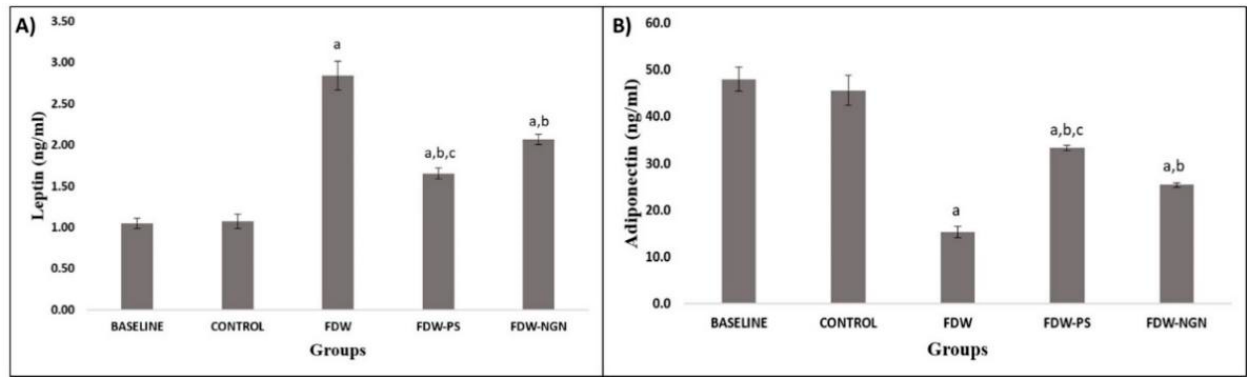
Figure 3. Leptin ( A ) and adiponectin ( B ) levels of all groups over 12 weeks. Values are mean ± SD and n = 8 for each group. Superscript letters indicate significantly different. a p < 0.05 compared to the control group. b p < 0.05 compared to the FDW group. c p < 0.05 compared to the FDW-NGN group. FDW: Olive oil + 20% fructose; FDW-PS: PS + 20% fructose; FDW-NGN: Naringin + 20% fructose.